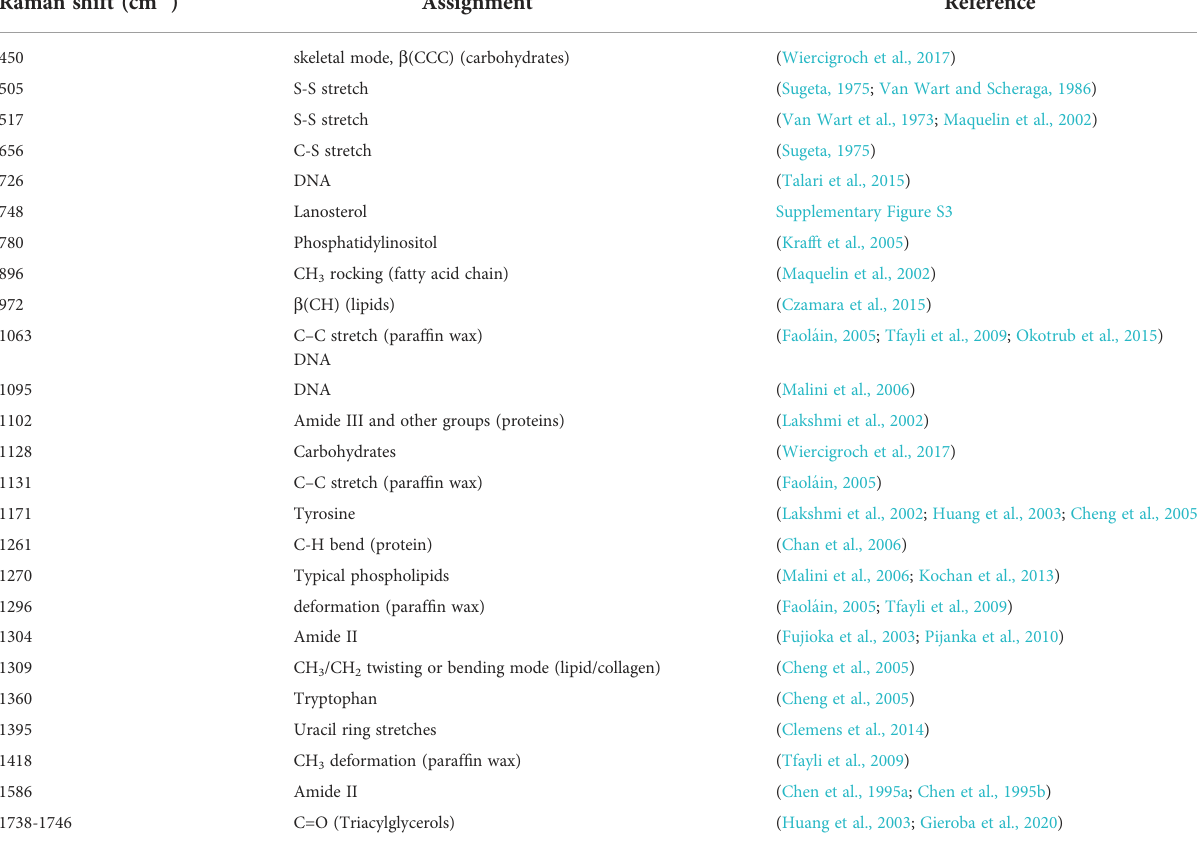
TABLE 1 Raman band assignment observed in the spectra of the